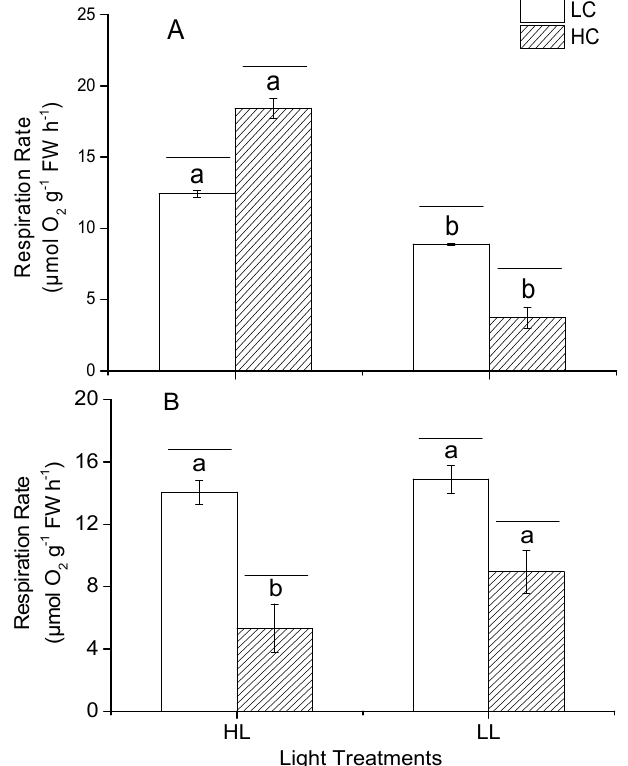
Figure 4. The instantaneous respiratory rate of Porphyra yezoensis under different CO 2 concentrations (400 μ atm, LC; 1000 μ atm, HC) and light treatments. ( A , B ) represent the instantaneous respiratory rate of algae under HL − LC, LL − LC, HL − HC, and LL − HC cultured after transferring to low CO 2 and high CO 2 concentrations, respectively. Values show the mean ± SD. Different letters (a and b) represent significant differences ( p < 0.05) at different light treatments under the same CO 2 levels.